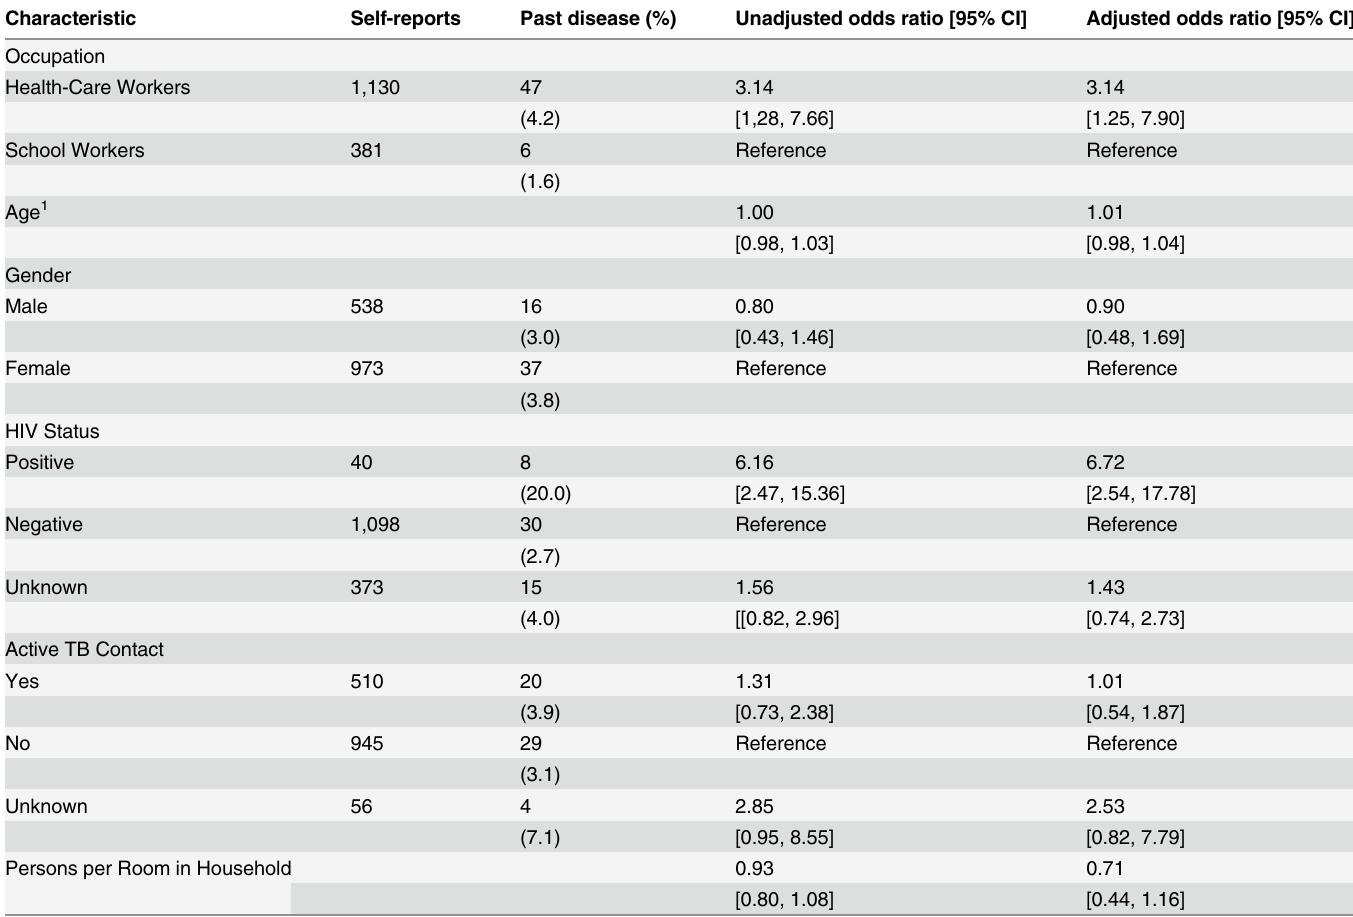
Table 3. Odds ratios for history of TB disease among health-care workers relative to school workers from Kigali, Rwanda, before and after adjust- ing for potential confounders. Characteristic